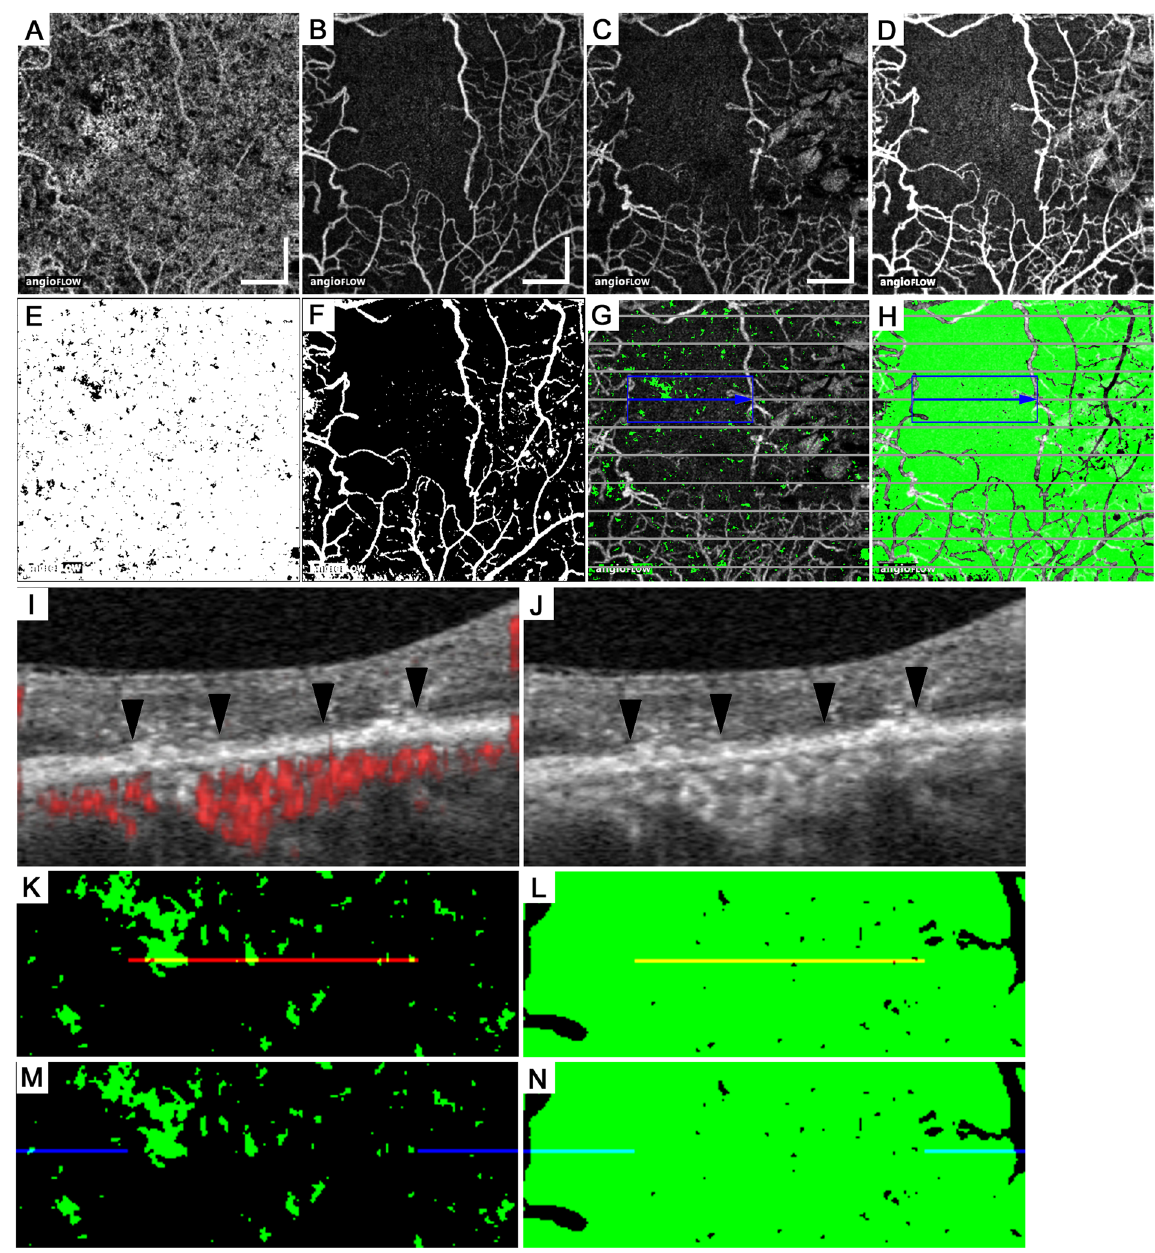
Figure 5. Association between photoreceptor damage and flow void in the choriocapillaris layer in a 46-year-old patient with PDR. En-face OCTA images in the 10- μ m-thick choriocapillaris layer ( A ) and the superficial ( B ) and deep ( C ) retinal capillary layers. ( D ) The merged image of the superficial and deep layers reveals ischemic maculopathy. The binary images of the flow void ( E ) or the artifacts ( F ). ( G , H ) The merged images of the deep capillary layer (panel C) and panel E or F with inverted signals (green). Both EZ status and decorrelation signals in the choriocapillaris layer were evaluated along the 10 gray lines. ( I , J ) The B-scan images with and without decorrelation signals (red) along the blue arrow in panels G and H demonstrate that the EZ line is not intact in the central region (arrowheads). The magnified images of areas of flow void (green; K , M ) and those without the artifacts (green; L , N ) within the blue rectangle in panels G and H. ( K , L ) The red lines correspond to the ‘not intact’ EZ line in panel I and partly colocalize with the areas of flow void. ( M , N ) The blue lines correspond to the ‘intact’ EZ line in panel I and rarely colocalized with the non-flow areas. Scale bar = 500 μ